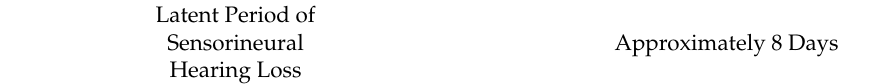
Table 3. Characteristics of coronavirus disease-related sudden sensorineural hearing